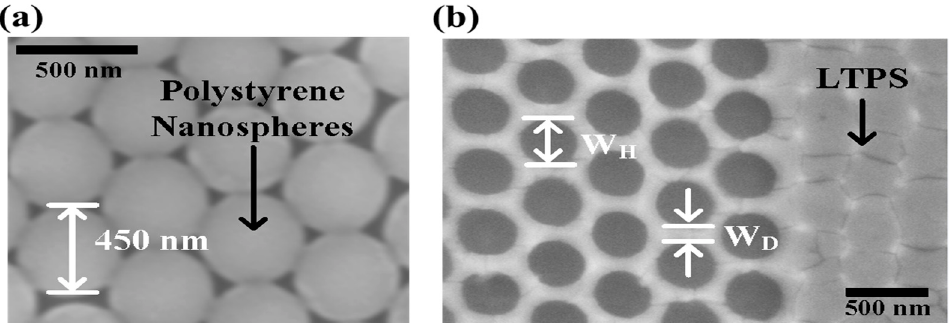
Figure 3. Top SEM images of ( a ) spin coated nanosphere after Figure 1c and ( b ) nanonet-channel after Figure 1g.